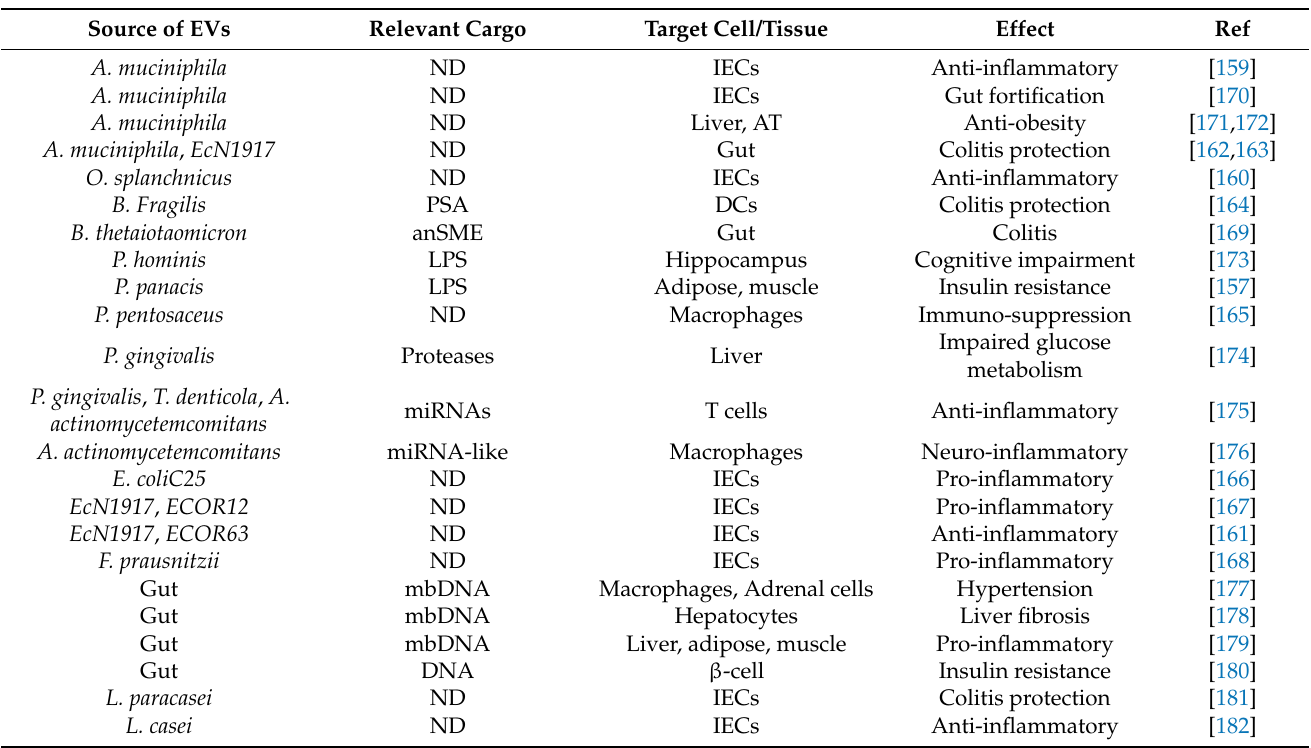
Table 2. Summary of the studies mentioned in the text dealing with bacteria-host EV-mediated inter-kingdom communication. See text for